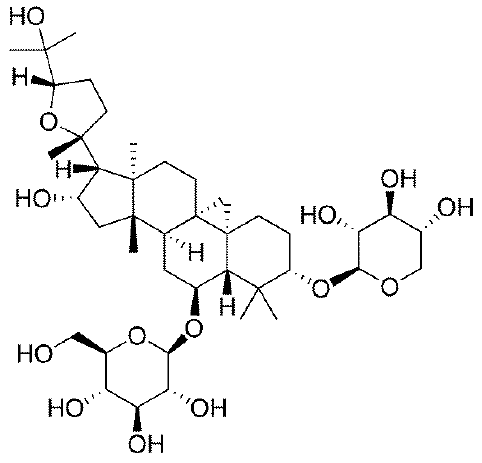
Figure 1. The chemical structure of AS-IV.